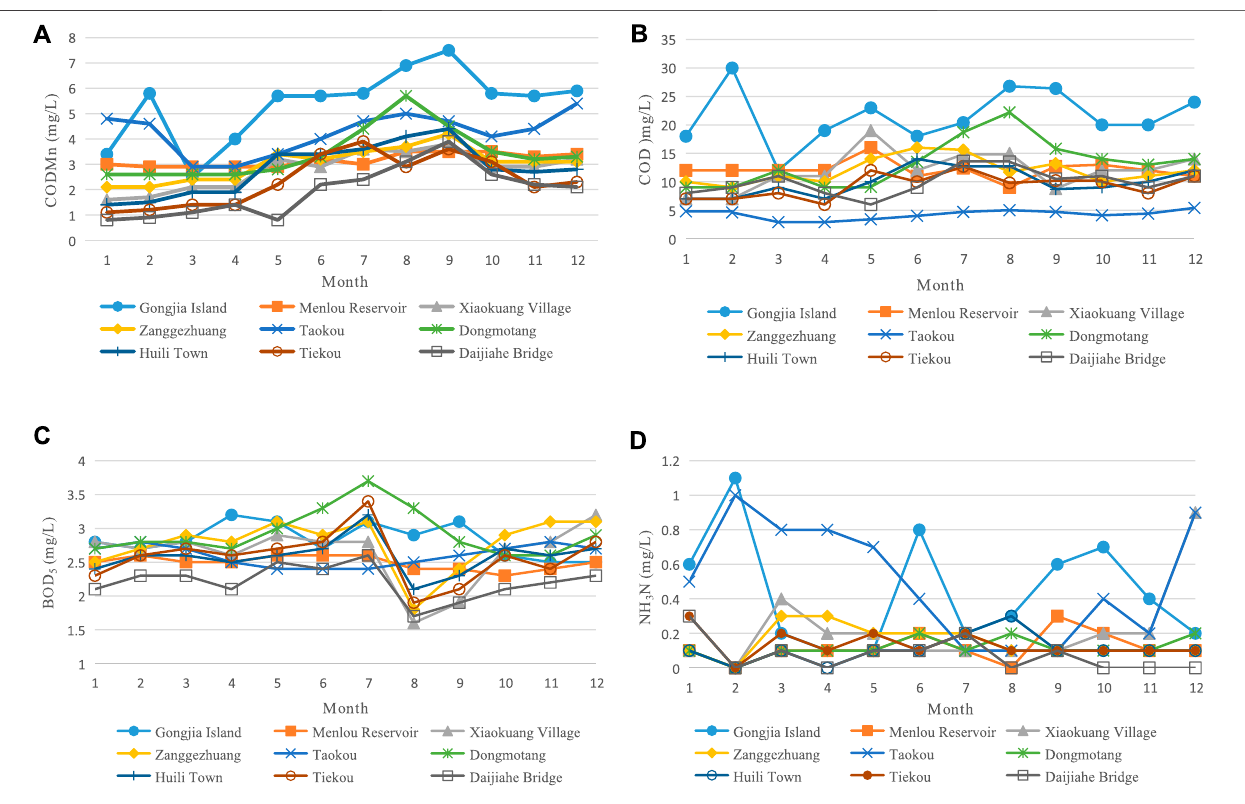
FIGURE5 | Organic oxygen consumptionpollutants (OCP) inthe Dangujia River inthe 2008 assessment year: (A) CODMn concentration, (B) COD concentration, (C) BOD5 concentrations, and (D) NH3N concentration.